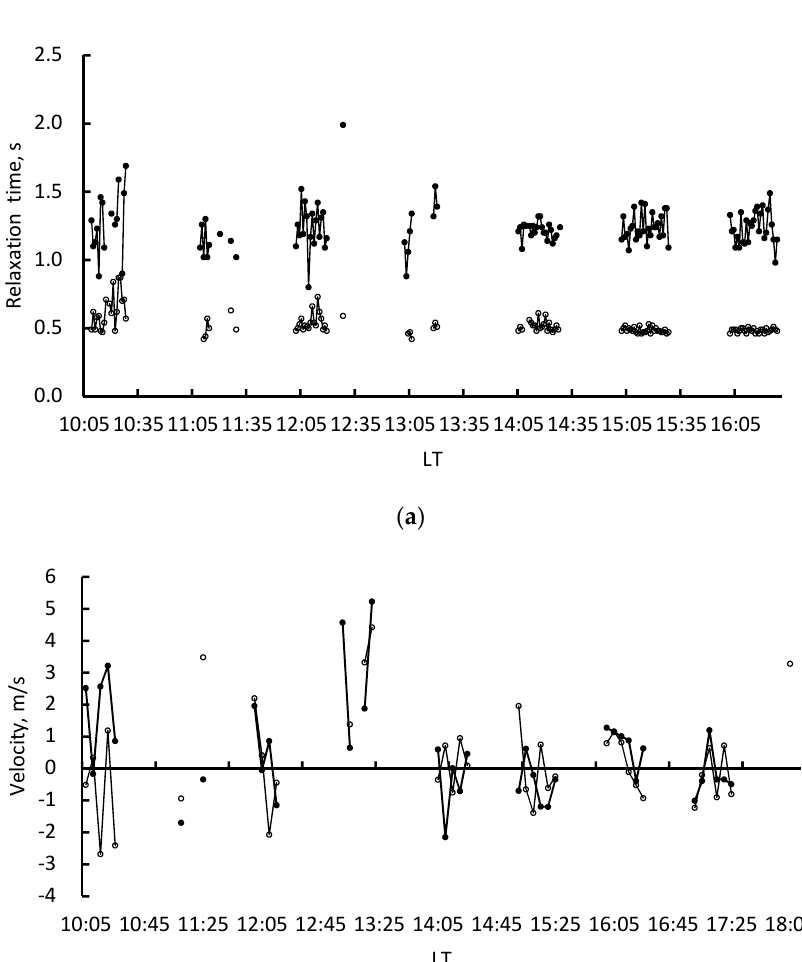
Figure 8. The time dependence of the relaxation time averaged over 1 min ( a ) and the time dependence of the vertical velocity averaged over 5 min ( b ) on heights of 65.8 km (circles) and 75.6 km (points) for 11 September 2019.